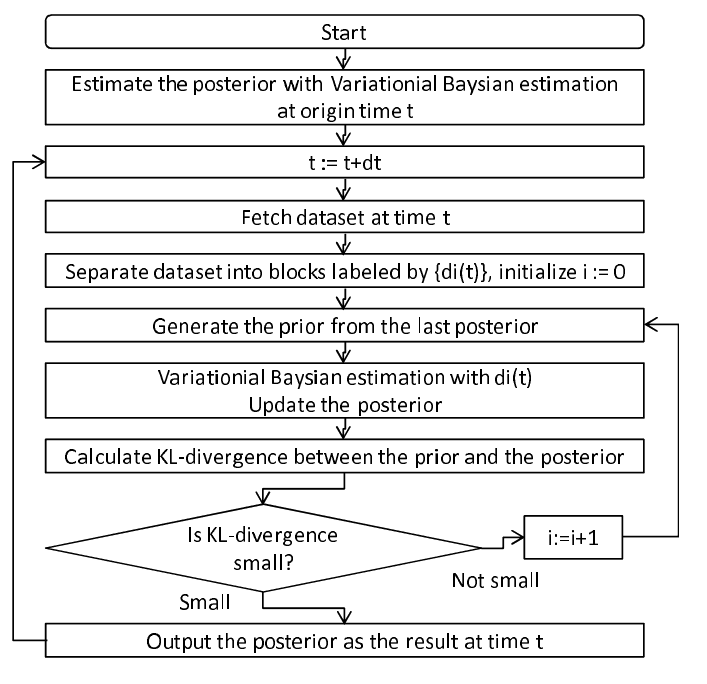
Figure 5. Proposed